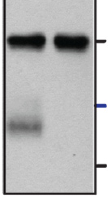
Figure 7. Determination of Sigma Lii Specificity for α 1.2 with 1 Conditional α 1.2 KO Mice. Sigma Lii immunoblots of Triton 1 X-100 extracts from cKO and WT mice using gels polymerized Figure 9. Detection of α 1.2 distal C-terminus. CNC2 immunoblots from 8% acrylamide. To fully resolve α 1.2 short and long forms, 1 1 showed an immunoreactive band migrating near 30 kDa in Triton electrophoresis was performed until the 100 kDa marker was X-100 forebrain extracts after immunoprecipitation with FP1. Signal near the bottoms of the gels. As with other antibodies tested (see was absent in immunoprecipitates from cKO samples. Gels were Figure 2), the ~210 and 250 kDa bands were nearly or completely polymerized from 13% acrylamide. Note that this interaction was absent in cKO samples. Arrows point to bands at 130 and 180 kDa variable, with roughly half of 8 IPs tested showing a clear, specific that are present in WT and cKO tissue. band, perhaps because this fragment is unstable and proteolytically degraded. Also, the 50 kDa bands are most likely the heavy chains of the immunoprecipitating